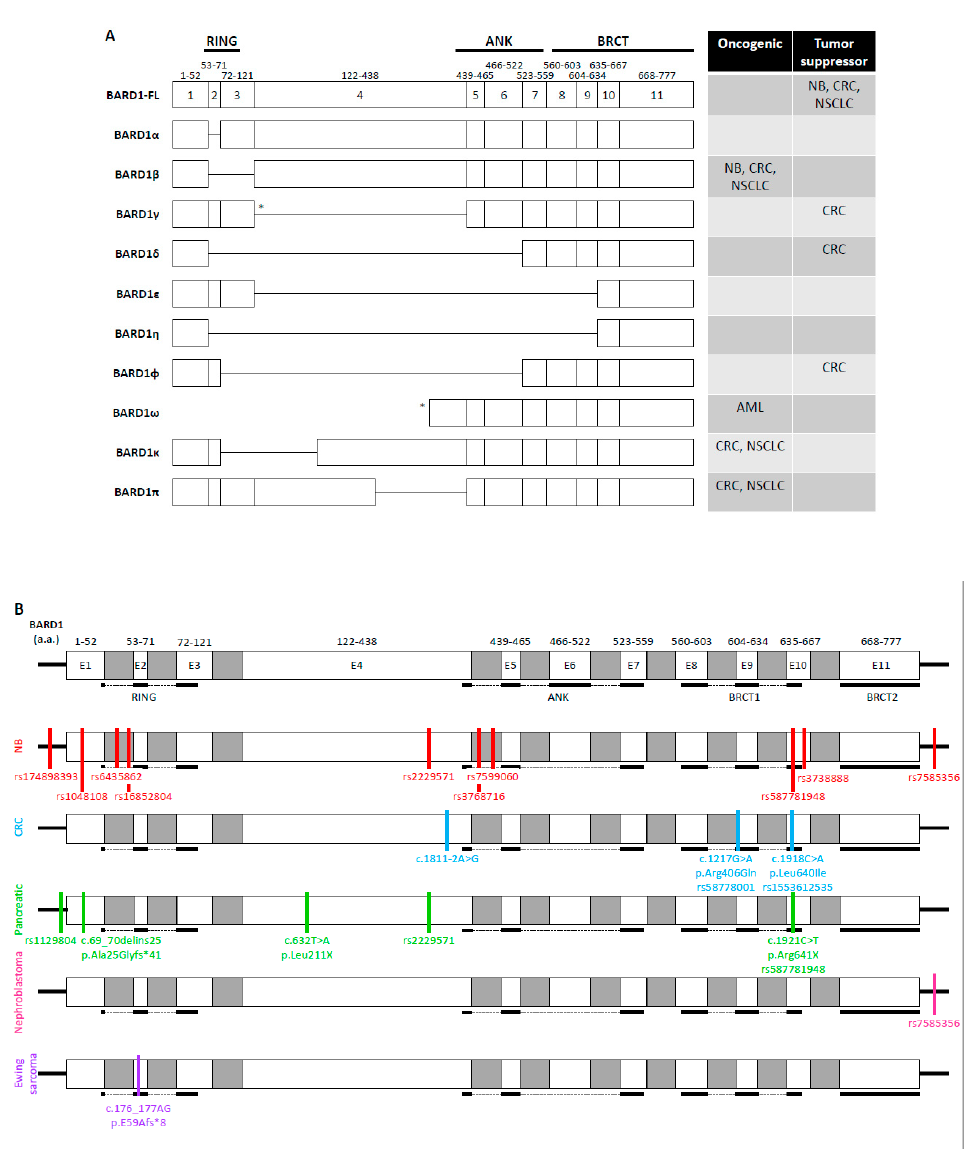
Figure 2. BARD1 variants in non-breast and non-gynecological cancers ( A ) BARD1 isoforms. Full-length BARD1 (BARD1-FL) and di ff erent variants that occur due to alternative splicing. The table depicts in which cancer types the isoforms are oncogenic or tumor suppressors. * indicates multiple forms of alternative splicing. The γ isoform is either composed of only exons 1–3 or exons 1–3, 5–11. The ω 1 isoform is depicted in this figure, which begins at a.a. 382. The ω 2 isoform begins in exon 4 at a.a. 407 while the ω 3 isoform begins in exon 7 at a.a. 538. NB: neuroblastoma. CRC: colorectal cancer. NSCLC: non-small cell lung cancer. AML: acute myeloid leukemia. ( B ) SNPs and genetic mutations in the BARD1 gene. BARD1 is composed of 11 exons (white) and introns (gray) and includes 5 ′ and 3 ′ UTR (black lines). Genetic variants of BARD1 in NB (red), CRC (blue), pancreatic cancer (green), nephroblastoma (pink), and Ewing sarcoma (purple) are depicted as lines localized to the region of the mutation. Only exons are drawn to scale.